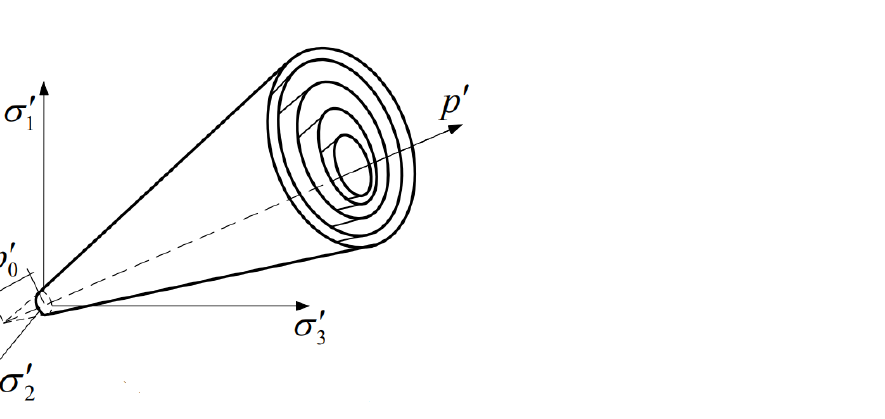
Figure 2. PressureDependMultiYield (PDMY) model: multi-yield surfaces in principal stress space.